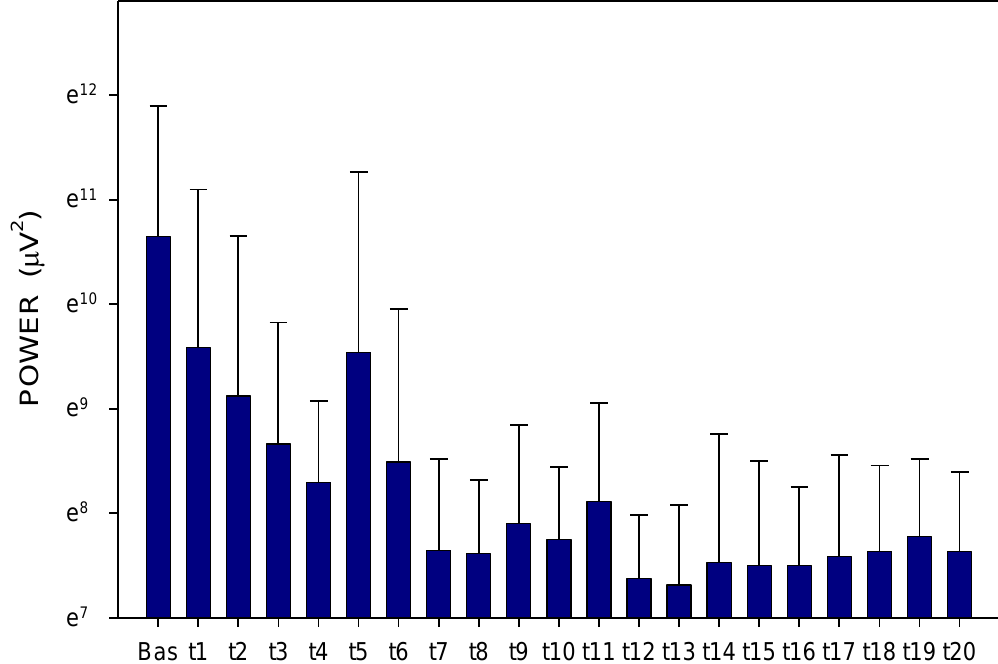
Figure 4. Electrogastrography. EGG power before and after a single intragastric administration of 24 mg galantamine in animals with previous 7-day administration of dextran sodium sulphate (mean + standard deviation). Outliers omitted. Axis Y: natural logarithm scale. Explanatory note: Bas: 15-min basal recording before galantamine administration; t: 15-min study recordings after galantamine administration (t1: time interval between 0–15 min ... t20: time interval between 286–300 min).